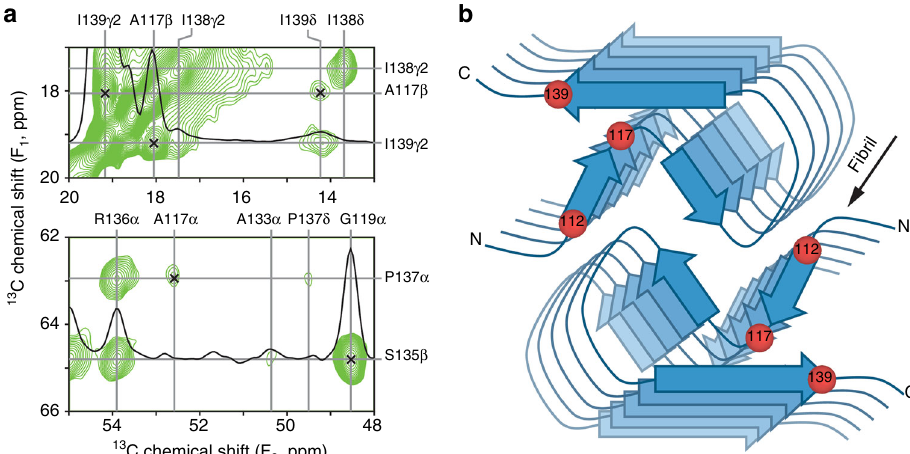
Fig. 2 Key interresidue contacts and schematic model of the human PrP23-144 amyloid β -core. a Small regions of a 900 MHz two-dimensional 13 C – 13 C DARR solid-state NMR spectrum recorded with a mixing time of 500 ms for amyloid fi brils generated from huPrP23-144 expressed with 3- 13 C-pyruvate as the carbon source. The spectral regions contain the key restraints on the [hu] amyloid core structure in the form of unambiguous long-range correlations (indicated by x-marks ) between the following 13 C atoms: A117C β -I139C γ 2, A117C β -I139C δ , A117C α -P137C α , and G119C α -S135C β . b Schematic model for the [hu] amyloid core based on the combination of solid-state NMR and tilted-beam transmission electron microscopy data (see text for details). In this model [hu] amyloid fi brils consist of two proto fi laments in a C 2 -symmetric arrangement with β -sheet regions running parallel to the long fi bril axis. The approximate locations of amino acid residues 112, 117, and 139, that have major impact on the structure adopted by PrP23-144 amyloid as discussed in the text, are indicated by red